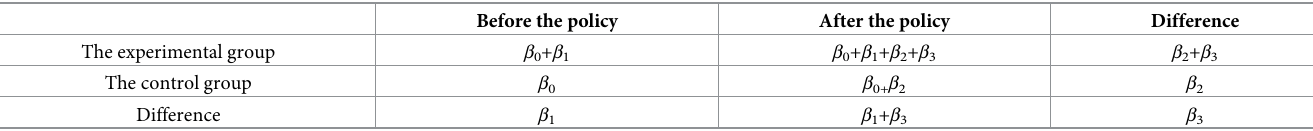
Table 2. Comparison of net effects before and after the implementation of the